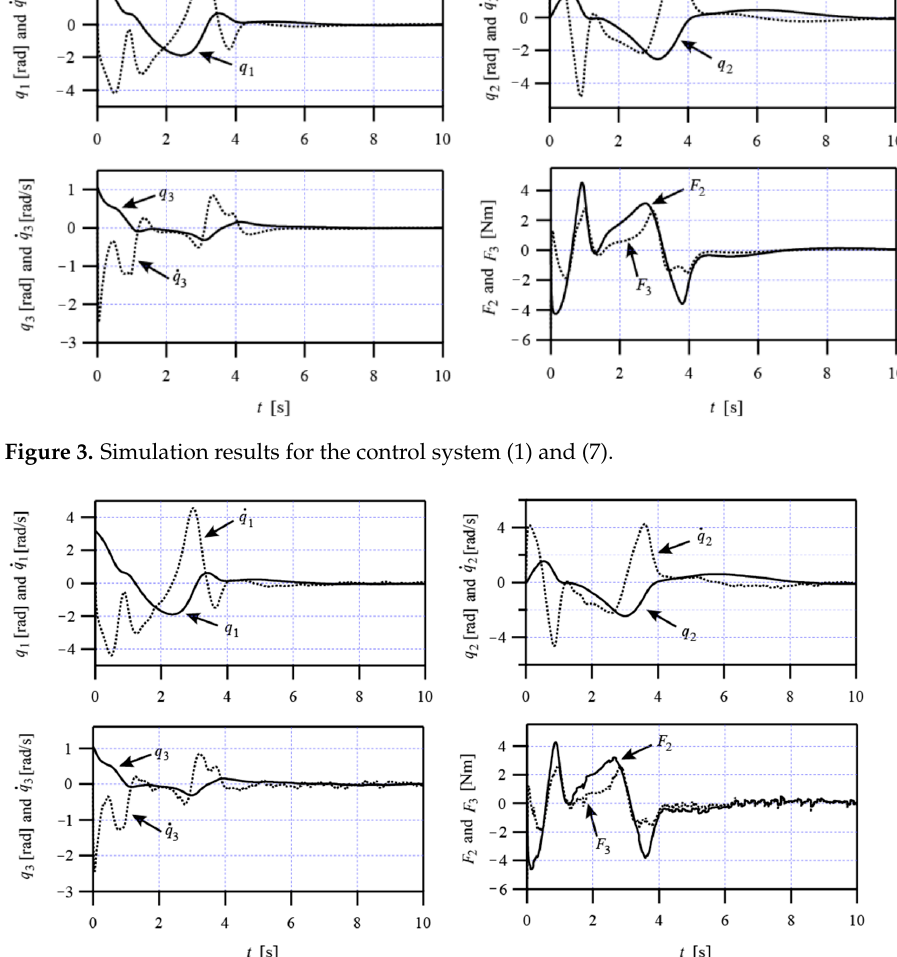
Figure 4. Simulation results for the control system (1) and (7) with parameter perturbation and external disturbances.